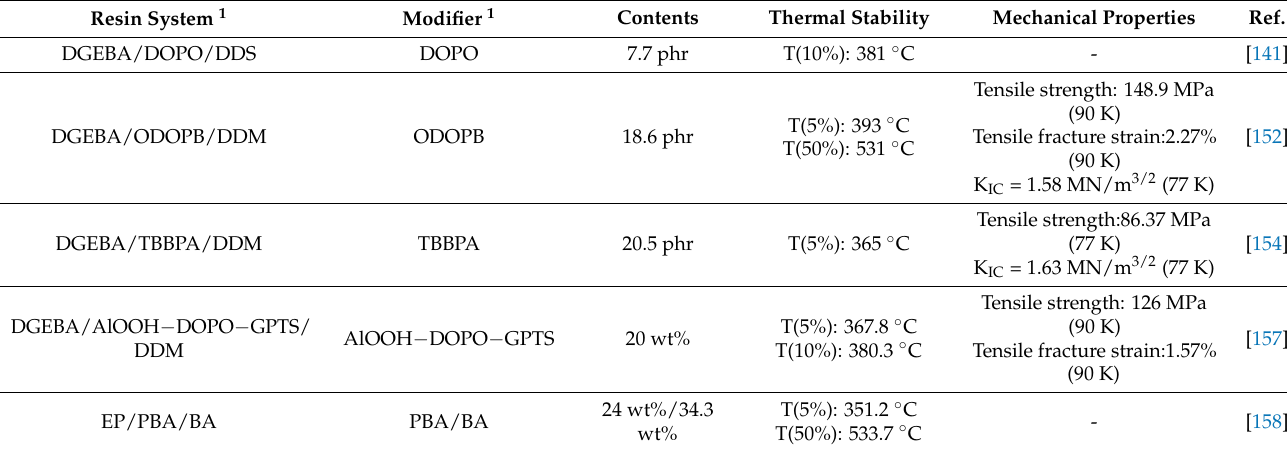
Figure 13. ( a ) the XPS spectra and ( b ) P2p peak fitting curves of the specimen before and after mechanical impact under the liquid oxygen environment. Reused with permission from Ref. [159]. Copyright 2016 Royal Society of Chemistry. Table 2. The cryogenic performance of the reported materials that has the potential ability for liquid oxygen system use. Resin System